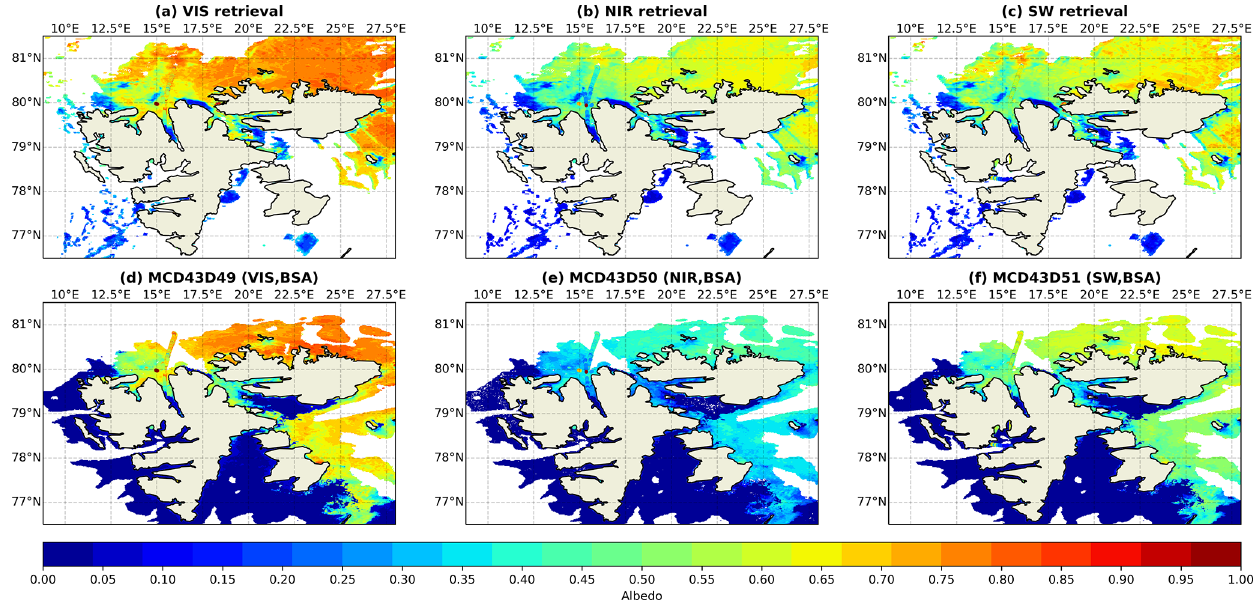
Figure 13. Albedo retrieval maps similar to Fig. 12 but on 26 June 2017.